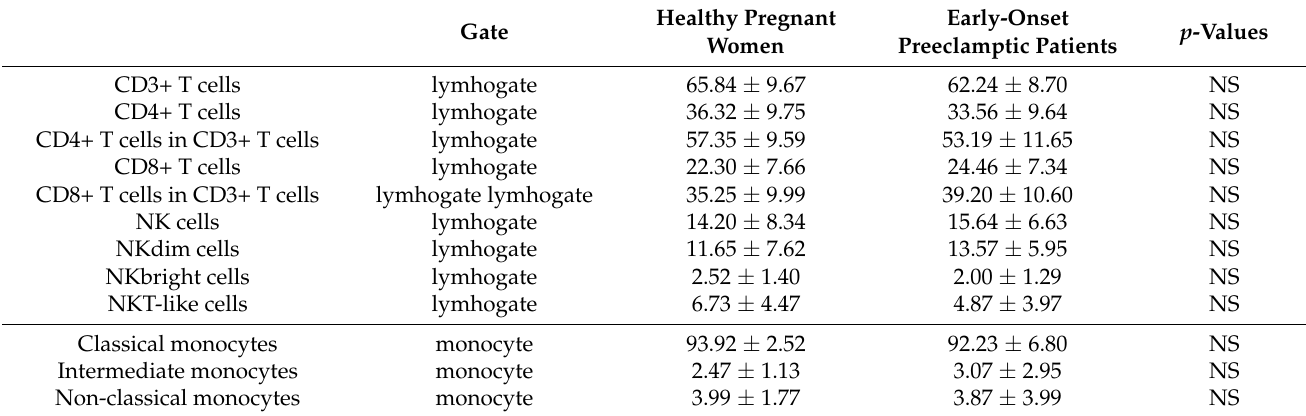
Figure 1. Gating strategy to detect lymphocyte subpopulations. Gating technique used to determine lymphocyte subpopu- lations from peripheral blood mononuclear cells. After a two-step doublet exclusion ( A , B ), the lymphocyte population was gated using FSC-A/SSC-A parameters ( C ). From the lymphogate CD3+ T-, NK-, NKdim-, NKbright-, NKT-, CD8+ T-, and CD4+ T cell subpopulations were detected ( D , E ). Table 3. Phenotype analysis of peripheral blood mononuclear cells in 3rd-trimester healthy pregnant women and women with EO